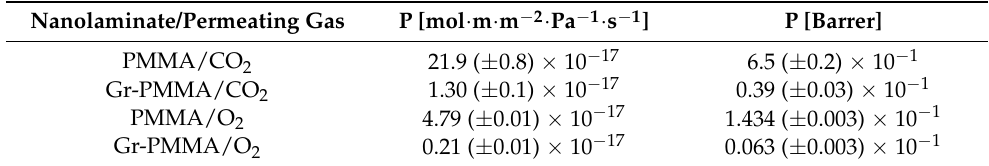
Figure 11. Gas permeability coefficients at 25 °C through poly(methyl methacrylate) (PMMA) (blue bars) and Gr-PMMA (poly(methyl methacrylate/graphene nanocomposite)) (red bars) for ( a ) CO 2 and humidified CO 2 and for ( b ) O 2 and humidified O 2 [120]. Reproduced with permission from MDPI. Table 2. Permeability coefficients of CO 2 or O 2 through the nanocomposite at different R.H. lev- els [120]. PMMA = poly(methyl methacrylate); Gr-PMMA = poly(methyl methacrylate/graphene nanocomposite). Reproduced with permission from